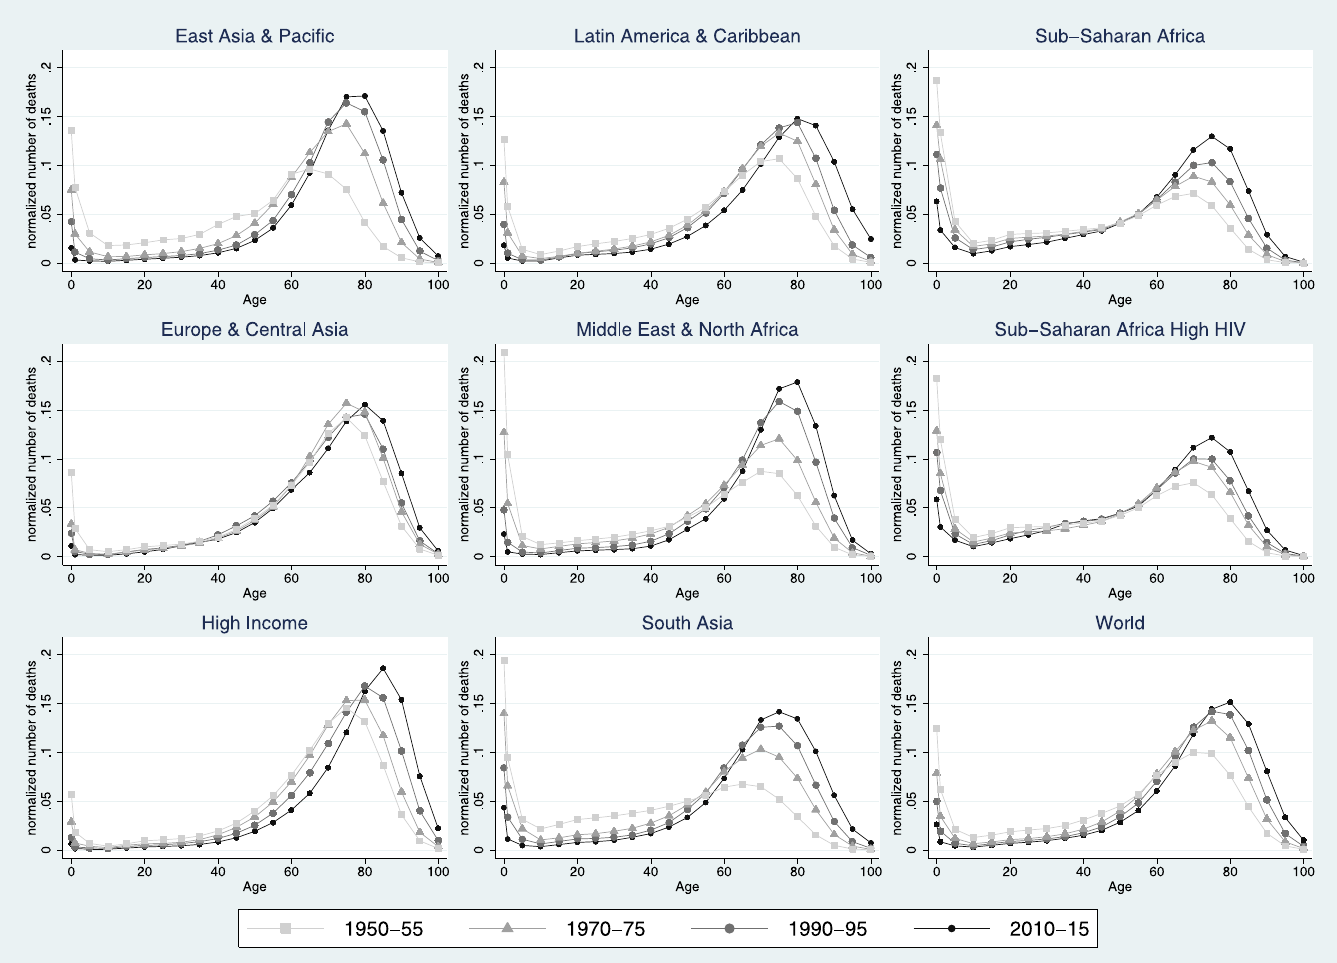
Fig 1. Density functions with age-at-death distributions in 1950–55, 1970–75, 1990–95, and 2010–15 in the world as a whole and in its regions. EAP = East Asia & Pacific, CA = Central Asia, HIC = High-income countries, LAC = Latin America & Caribbean, MENA = Middle East & North Africa, SA = South Asia, SSH-HIV = Sub- Saharan Africa High HIV, SSA = Other Sub-Saharan African countries. Source: Authors’ calculations based on UN World Population Prospects data.